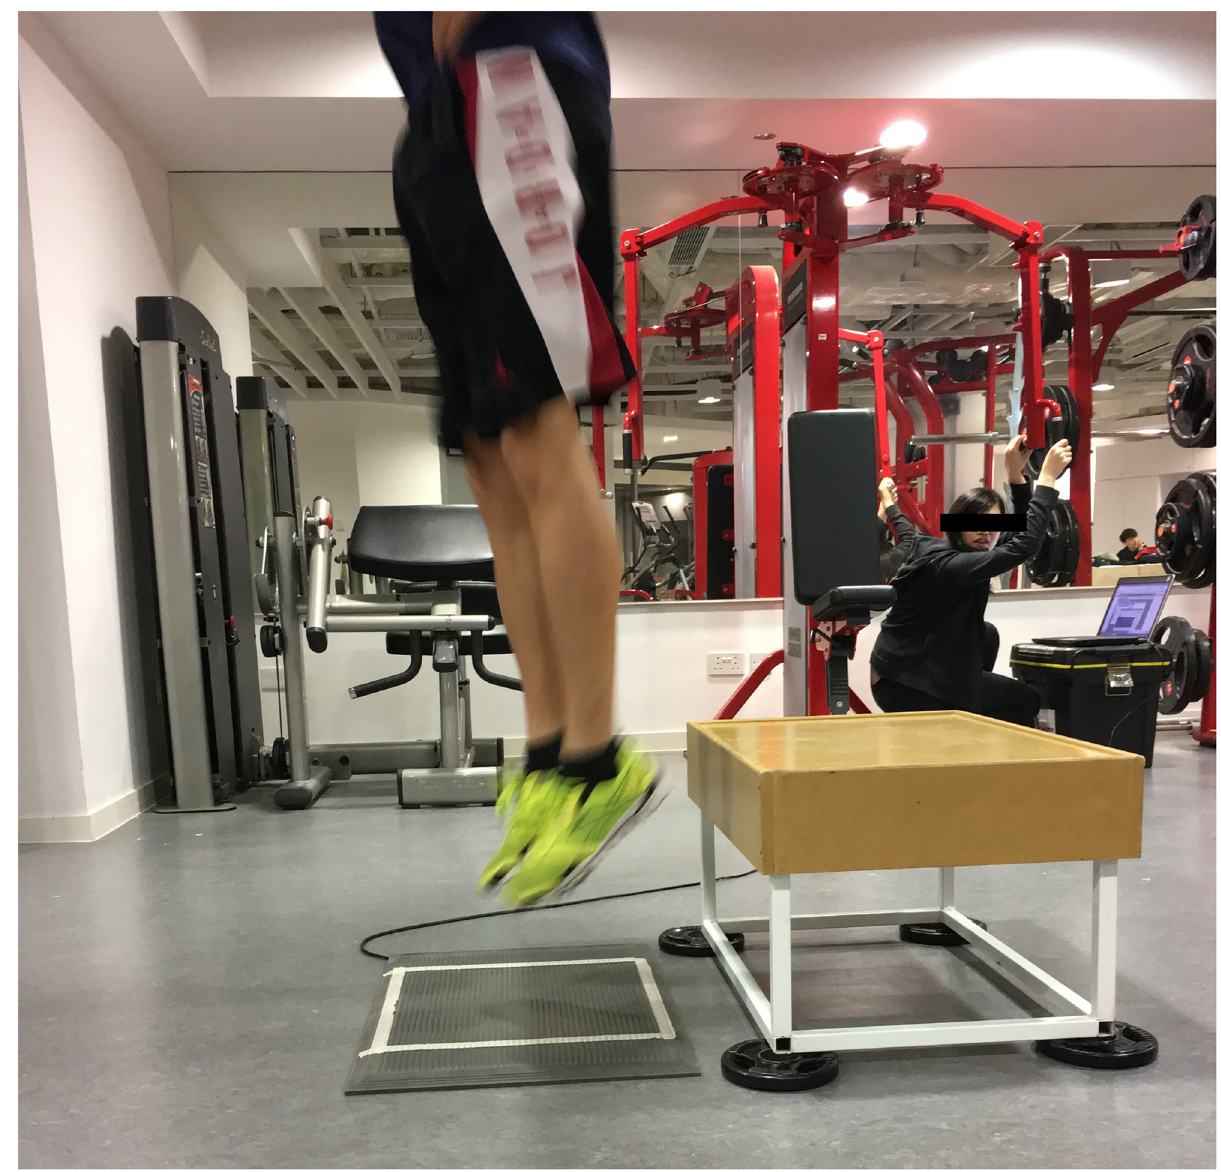
Fig 3. Drop jump